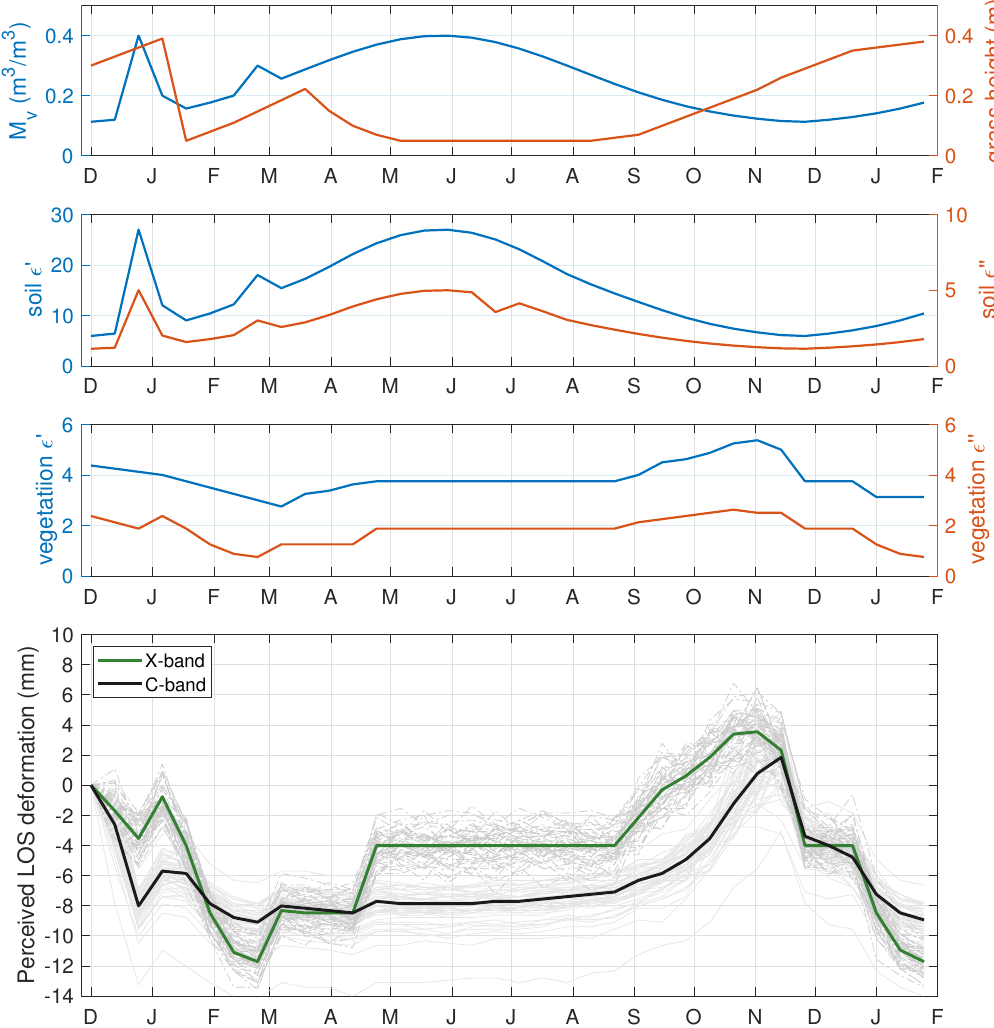
Figure 4. Hypothetical values of soil moisture ( M v ), grass height, and soil and vegetation permittivities (for C-band) over 14 months in a pasture without terrain motion ( the top three plots ) and the resulting synthetic perceived LOS deformation through phase disturbances ( bottom plot ) of C-band and X-band microwave radar: our “year in a paddock” included realistic scenarios of southern hemisphere pasture with (sub-)seasonal changes in soil and vegetation moisture due to some heavier showers (December and March), grass and soil drying out over summer (December to March), a grass-cut (January), cattle grazing (March–May), and grass not growing over winter